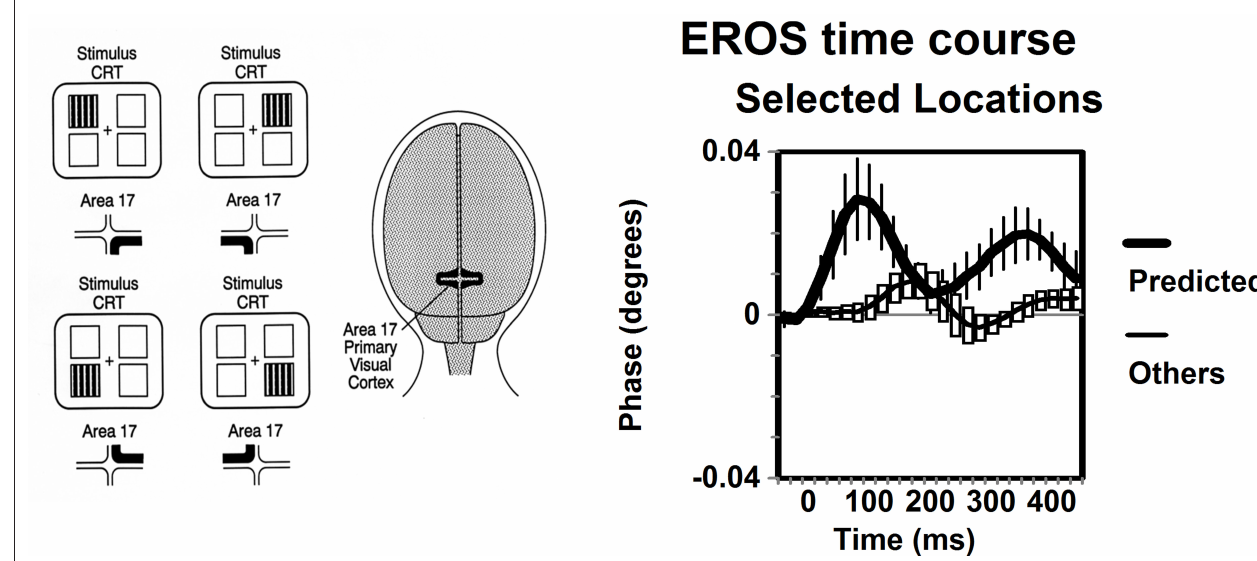
averaged across the four stimulation conditions (thick lines), and the responses from the same locations when the other stimulation conditions where presented (thin lines). Error bars are based on the standard error of the mean ( N =